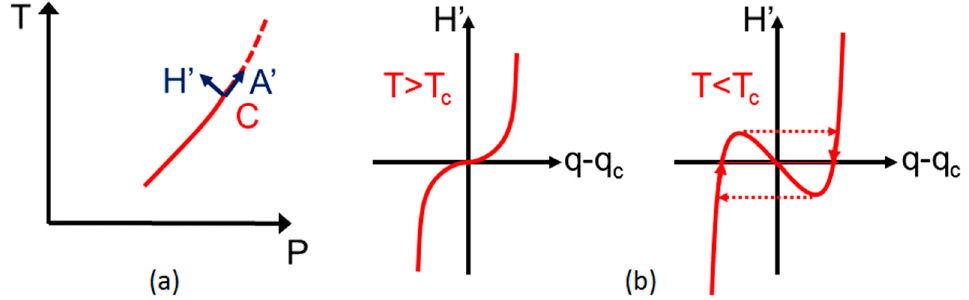
Figure 5. Schematic drawing of the (P,T) phase diagram for an isostructural transition ( a ) and of the equation of state above (crossover regime) and below (bistable regime) the critical end point C ( b ).